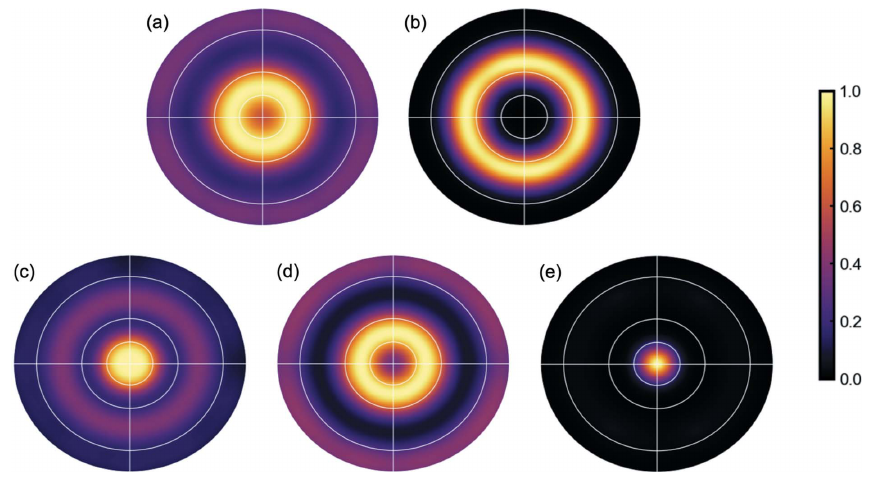
Figure 7 Real-space pole figures derived from the txPDF G ( r ). Peaks: ( a ) 0 ; 1 = 2 ; 1 = 2, ( b ) 0, 0, 1, ( c ) 1 = 2 ; 1 = 2 ; 1, ( d ) 0, 1, 1 and ( e ) 1, 1, 1.